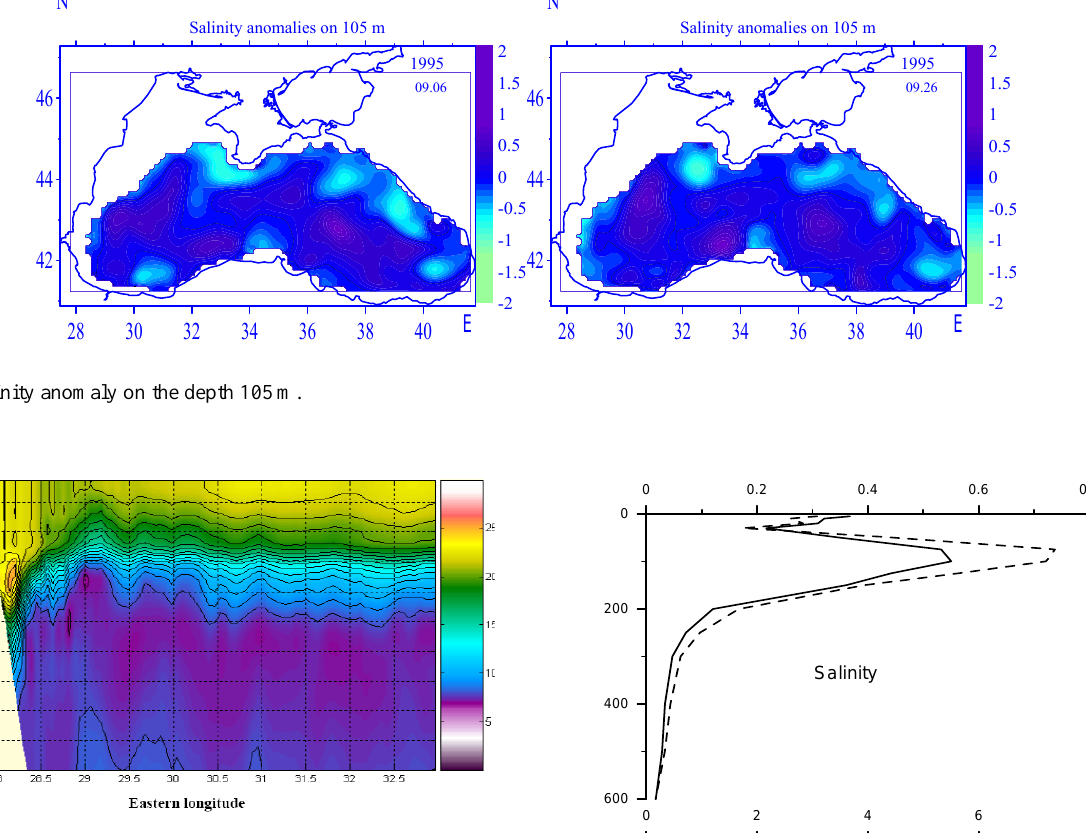
Figure 6 Temperature section along 42.7 ˚ N in the upper 100m on 29 September 2005. Contour interval Fig. 6. Temperature section along 42.7 ◦ N in the upper 100m on 29 is equal to 1 ˚ C. The lowest and the next isotherms correspond to 8 ˚ C and bound the CIL section. September 2005. Contour interval is equal to 1 ◦ C. The lowest and the next isotherms correspond to 8 ◦ C and bound the CIL section. The Rim current frontal zone can be clearly seen in the left part of the section. The deepening of the thermocline as well as the Rim current jet is attached to the bottom slope. General features of the basin dynamics and stratification are well presented by model results.